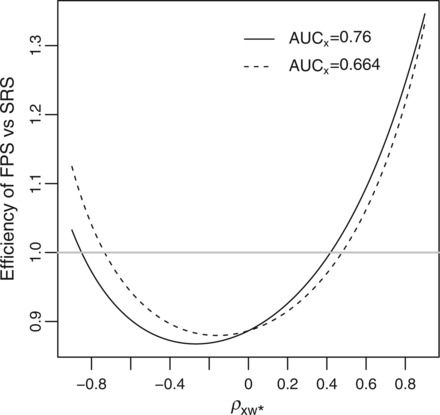
Efficiency of \documentclass[12pt]{minimal}
\usepackage{amsmath}
\usepackage{wasysym}
\usepackage{amsfonts}
\usepackage{amssymb}
\usepackage{amsbsy}
\usepackage{upgreek}
\usepackage{mathrsfs}
\setlength{\oddsidemargin}{-69pt}
\begin{document}
}{}$\widehat {{\rm AUC}}(\hat {p})$\end{document} in finite-population stratified sampling (FPS) of controls relative to the empirical AUC estimator in simple random sampling (SRS) without replacement of controls. Efficiency = asymptotic variance of empirical AUC estimator in SRS (equation (4.2))/asymptotic variance of \documentclass[12pt]{minimal}
\usepackage{amsmath}
\usepackage{wasysym}
\usepackage{amsfonts}
\usepackage{amssymb}
\usepackage{amsbsy}
\usepackage{upgreek}
\usepackage{mathrsfs}
\setlength{\oddsidemargin}{-69pt}
\begin{document}
}{}$\widehat {{\rm AUC}}(\hat {p})$\end{document} in FPS (equation (4.1)).